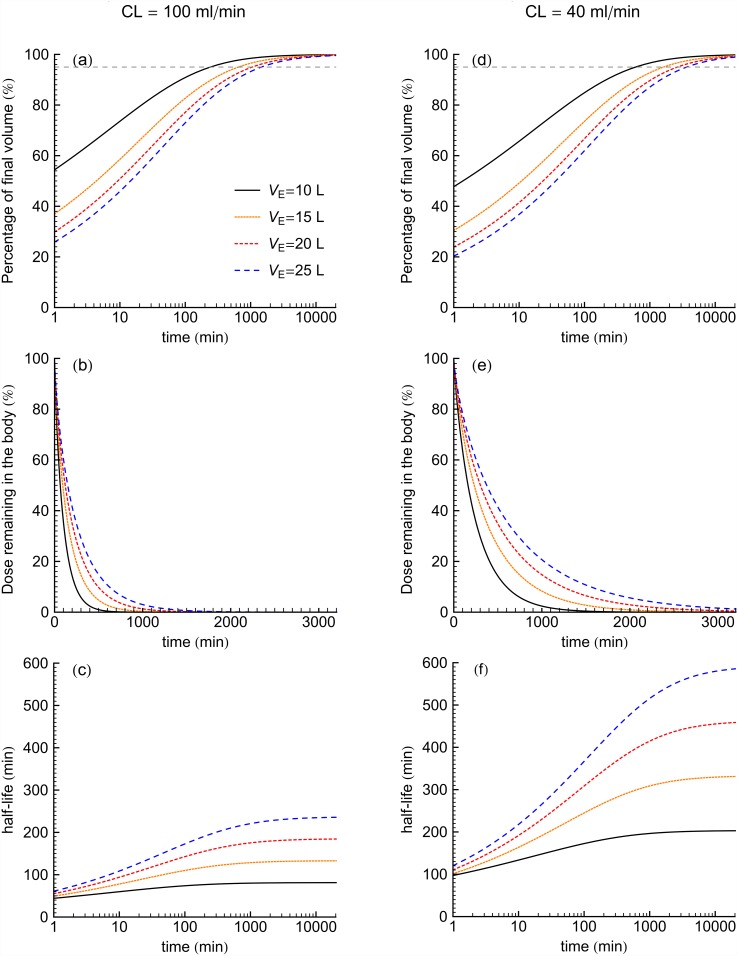
For GV models for 4 VE values at CL of 100 ml/min (left panel) and 40 ml/min (right panel), the percentage of terminal apparent volume, percent dose mass in time and half-life of the drug as a function of time.Dashed horizontal line indicates 95% of final volume.